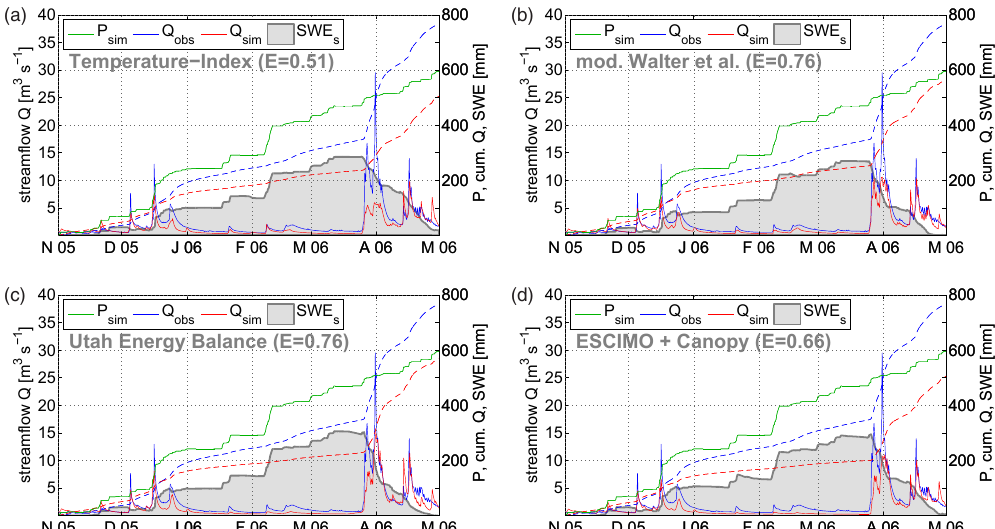
Figure 12. Streamflow simulations at the catchment scale using downscaled meteorological time series for the winter season 2005–2006: (a) temperature-index approach, (b) modified Walter et al. (2005) approach, (c) Utah Energy Balance model, and (d) ESCIMO + Canopy. For every simulation run, downscaled precipitation depth ( P sim ), observed streamflow ( Q obs , blue line), observed runoff depth (blue dashed line), simulated streamflow ( Q sim , red line), simulated runoff depth (red dashed line), and simulated snow water equivalent (SWE s ) are plotted. Model efficiencies E are also given for each run.